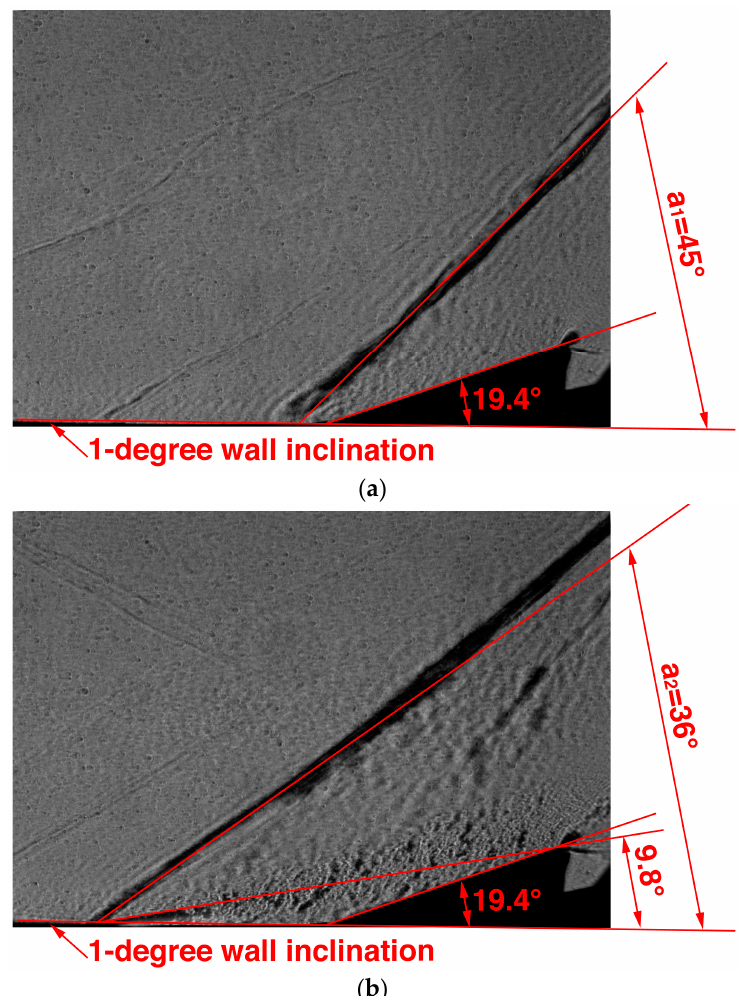
Figure 6. Typical snapshot images of schlieren visualization: ( a ) Flow without plasma actuation; ( b ) shifted shock wave ahead of plasma.